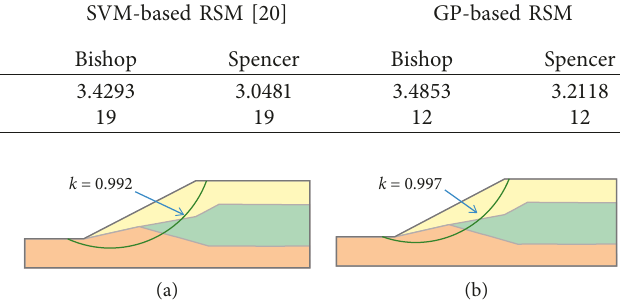
Figure 8: Example 3: results of the stability analysis. Slip surface at 0.992) and (b) the the design point by (a) the Bishop method ( F s (cid:28) Spencer method ( F s (cid:28)